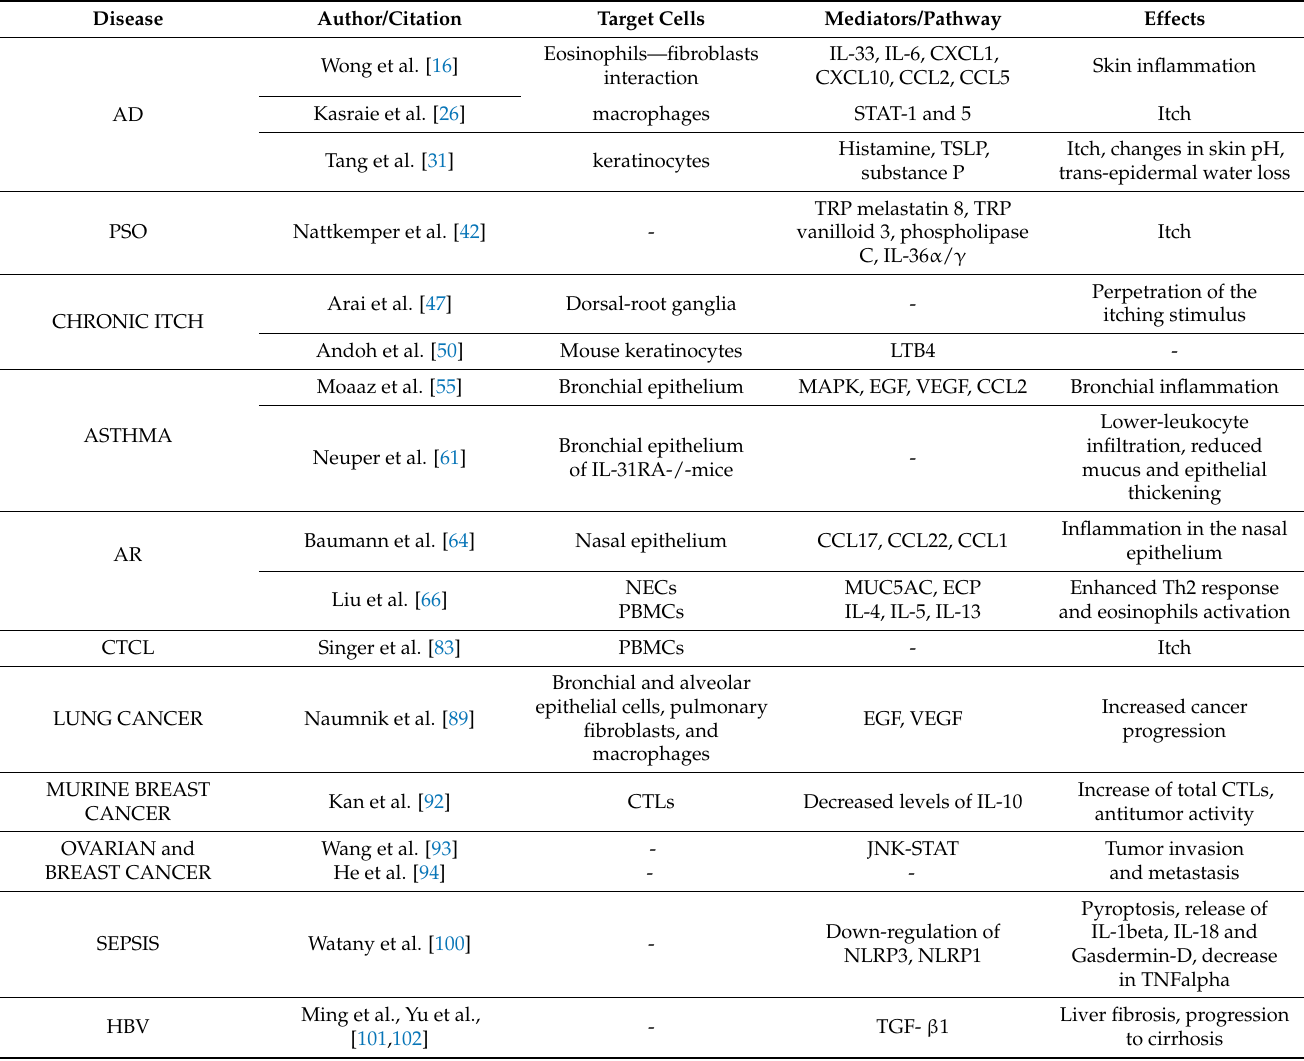
Table 1. Summarizes the main cellular targets, the mediators involved, and the effects of IL-31 in the pathologies treated in the main text. AD, atopic dermatitis. AR, allergic rhinitis. CCL1,2,5,17,22 C-C Motif Chemokine Ligand 1,2,5,17,22. CTCL, Cutaneous T-cell lymphoma. CTLs, Cytotoxic T lymphocytes. CXCL1, 10, C-X-C Motif Chemokine Ligand 1,10. ECP, Eosinophil cationic pro- tein. EGF, epithelial growth factor. HBV, hepatitis B virus. IL-1,4,5,6,10,13,18,31,33,36, interleukin 1,4,5,6,10,13,18,31,33,36. JNK-STAT, Janus kinase/signal transducer and activator of transcription. LTB4, leukotriene B4. MAPK, mitogen-activated protein kinase. MUC5AC, Mucin 5AC. NECs, nasal epithelial cells. NLRP1,3, NOD-, LRR-, and pyrin-domain-containing protein 1,3. PBMCs, peripheral- blood mononuclear cells. PSO, psoriasis. STAT-1,5, signal transducer and activator of transcription 1,5. TGF- β 1, transforming growth factor beta 1. TNF-alpha, tumor necrosis factor-alpha. TRP, transient receptor potential. TSLP, thymic stromal lymphopoietin. VEGF, vascular-endothelial-growth